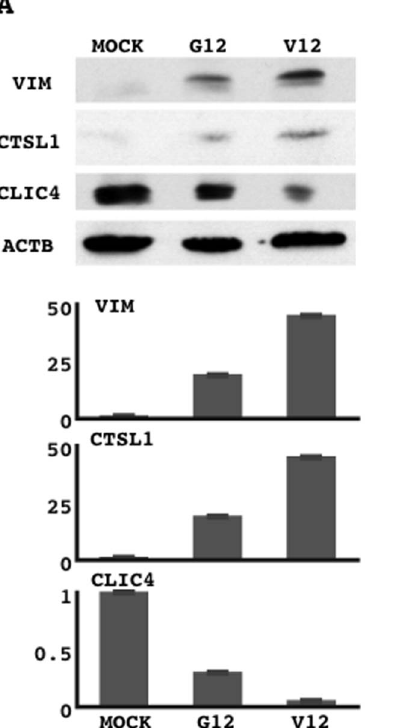
Figure 1. Protein lysates from mock-transduced NHBE-T cells (MOCK), wild-type KRAS G12-transduced NHBE-T cells (KRAS/ G12), and mutant KRAS V12-transduced cells (KRAS/V12), were labeled with the Cy2 (violet), Cy3 (green), and Cy5 (orange red) fluorescent dyes, respectively. Equal amounts of labeled protein from MOCK and KRAS/V12 (left panel) or from KRAS/G12 and KRAS/V12 (right panel) were mixed and subjected to 2-dimensional electropho- resis (A). The signal intensities of all the spots detected were comprehensively evaluated and subjected to hierarchical clustering analysis (Ward’s method) (B). Whole cell protein lysates were subjected to Western blot analysis for the expression of KRAS and b -actin (ACTB)